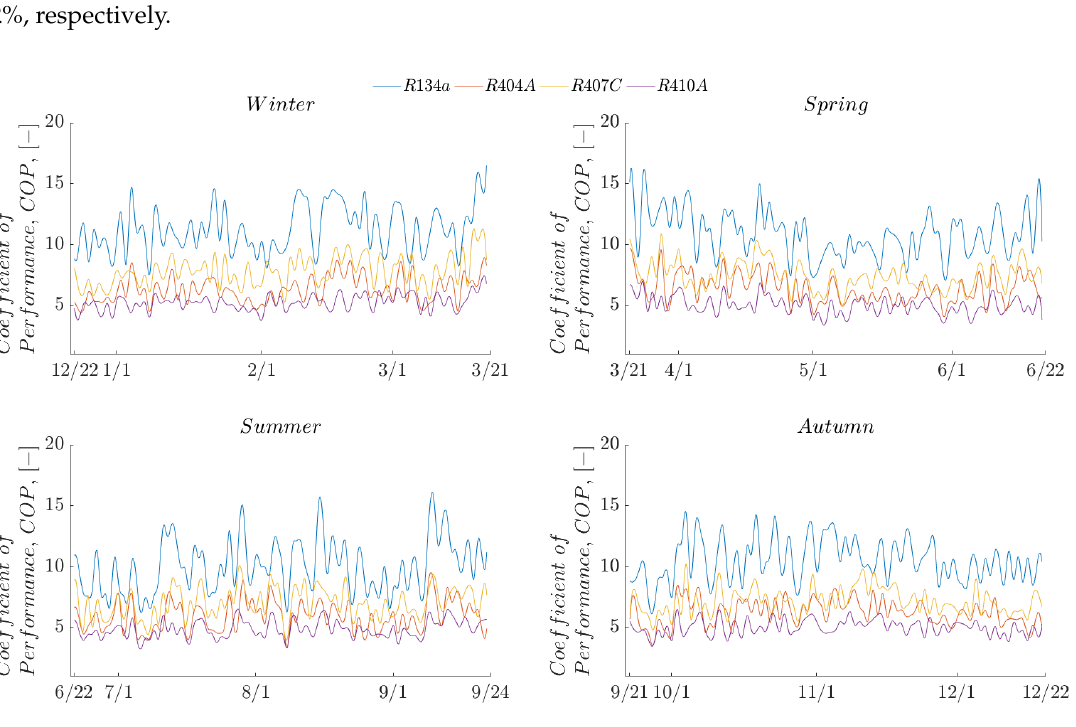
Table 9. Main statistics of the optimized coefficient of performance.